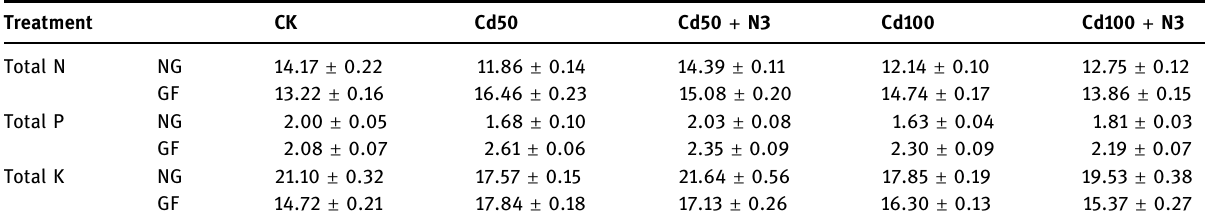
Table 1: Total N, P, and K in grafted and nongrafted plants ( mg g − 1 )